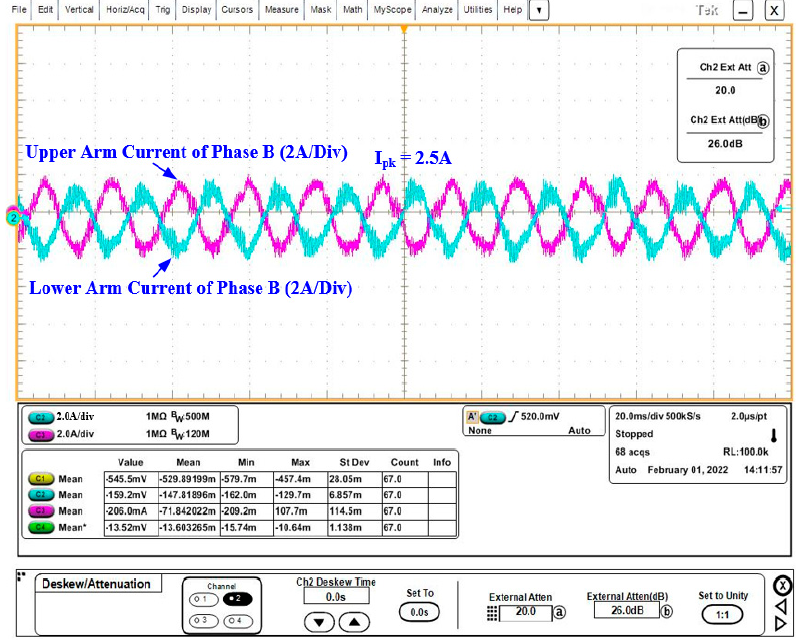
Figure 16. Arm Currents of phase B under steady state.